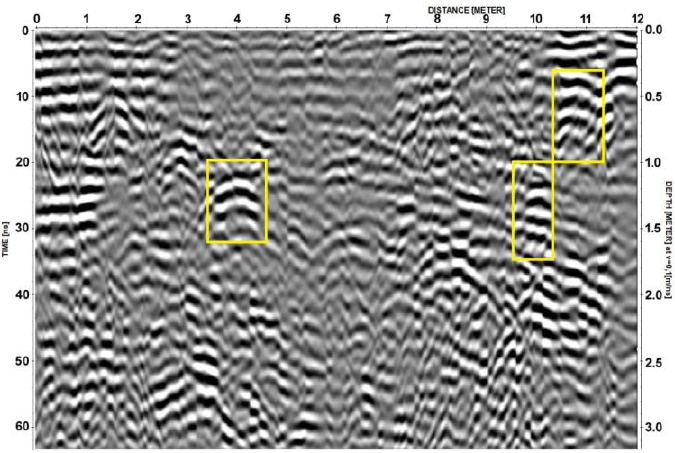
Figure 9. GPR reflection profile from GPR 2 area, profile 2, X3M device with shielded antenna 500 MHz. Yellow rectangle marks anomalous zones.